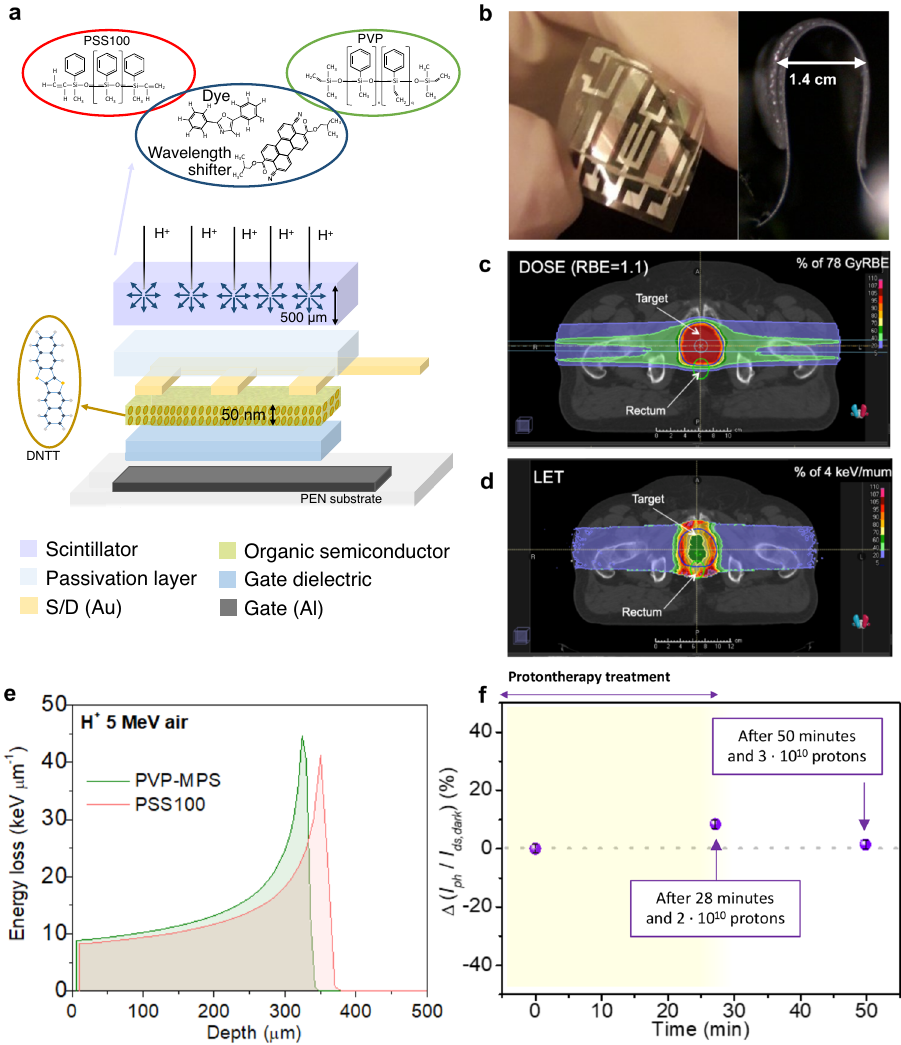
Fig. 1 Flexible fully organic indirect proton detector. a Detector cross-section scheme. The layer dimensions and relative thicknesses are out of scale. Chemical structures and thicknesses of the organic semiconductor and the scintillator layers are also indicated. b Flexible indirect proton detector 2 × 2 matrices. c , d Monte Carlo simulations of a single treatment run, reaching a total dose of 2 Gy on the cancer volume by protons irradiation with energy in the range (162 ÷ 197) MeV: dose distribution as % of 78 GyRBE ( c ) and dose-average LET distribution as % of 4 keV µm − 1 ( d ). e Simulated curves of the energy loss of each 5 MeV proton impinging in PSS100-(red) and PVP-MPS-(green) based scintillators. The area below the curves corresponds to the total energy released inside the material. f Reliability of the detector response benchmarked by measuring the photocurrent signal rise upon irradiation with a fi xed proton fl ux (i.e., 6.5 × 10 7 H + s − 1 cm − 2 ) at the beginning of the experiment, i.e., unirradiated device, and after fi xed total proton irradiation (2 × 10 10 H + and 3 × 10 10 H + ). The yellowish region indicates the temporal window typical of a proton therapy